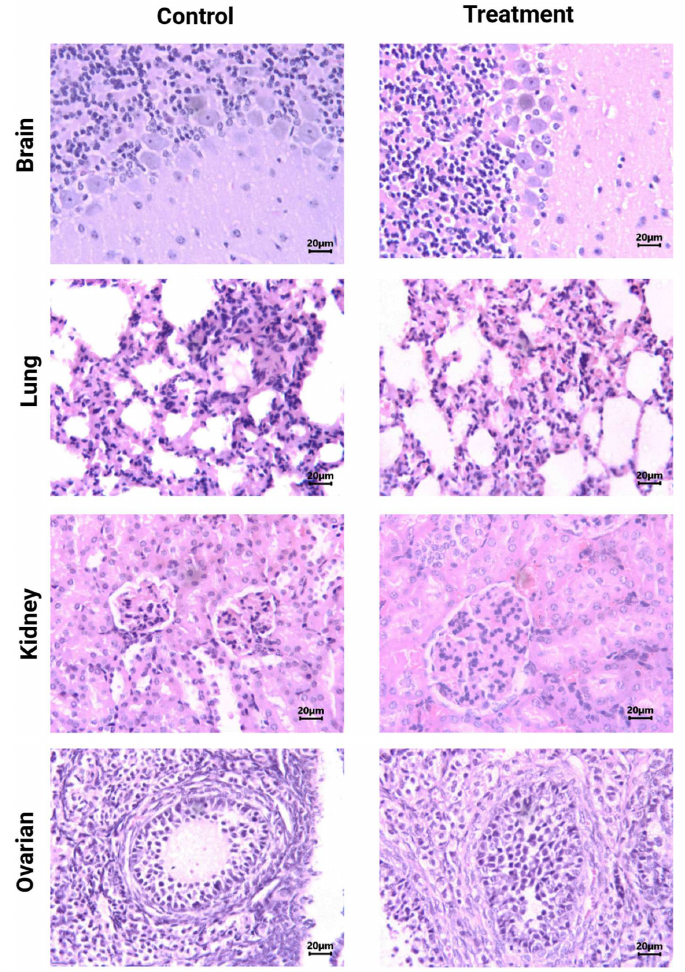
Figure 4. Histological analysis (H&E staining). Light micrographs of representative sections at 400× magnification of brain, lung, kidney, and ovarian tissues from [ 177 Lu]Lu−iFAP/iPSMA-treated and untreated (control) mice. Note that tissue toxicity was not found in neither treated nor control mice.